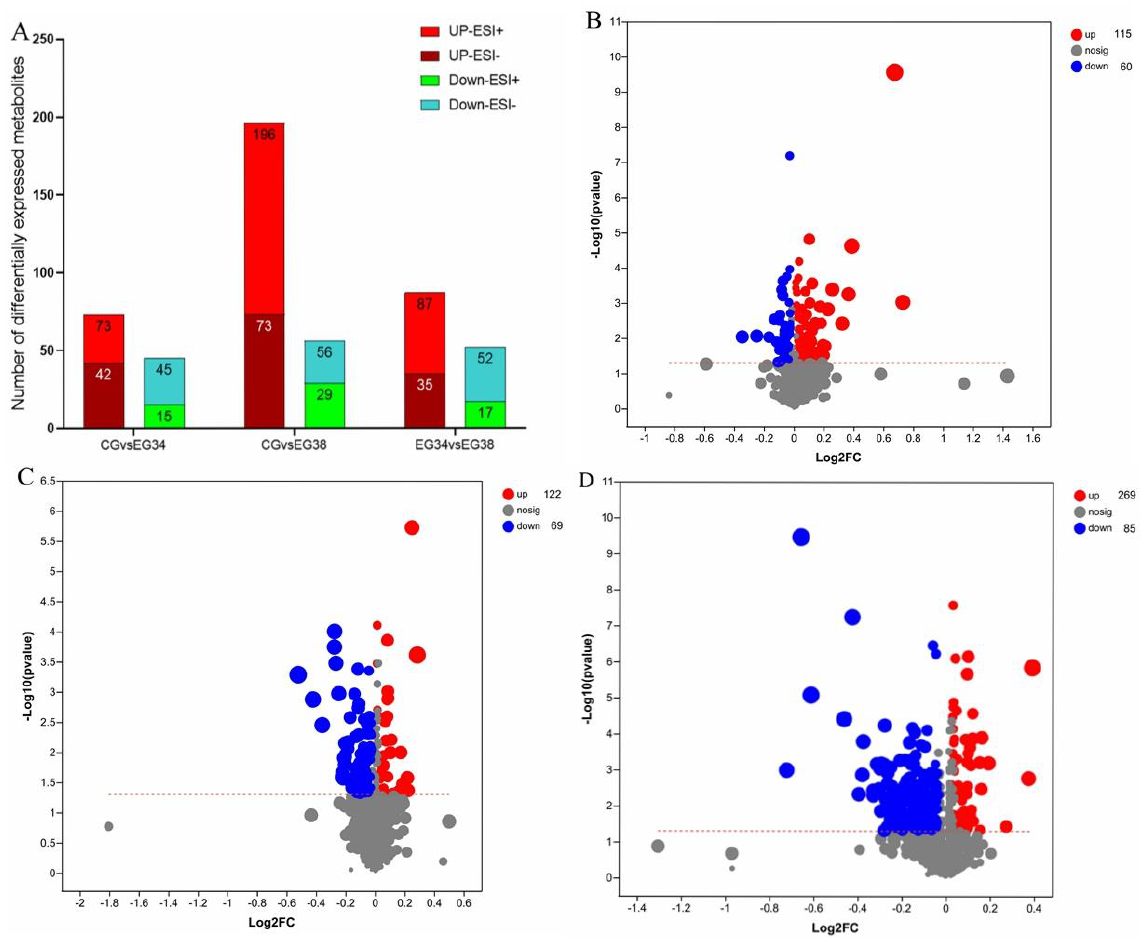
Figure 5. Differentially expressed metabolites in three comparison groups: ( A ) summary of the various metabolites in the two comparison groups; ( B ) volcano plot of the differentially expressed metabolites in the CG and EG34 groups; ( C ) volcano plot of the differentially expressed metabolites in the CG and EG38 groups; and ( D ) volcano plot of the differentially displayed metabolites in the EG34 and EG38 groups. Table 1. Significantly different metabolites.